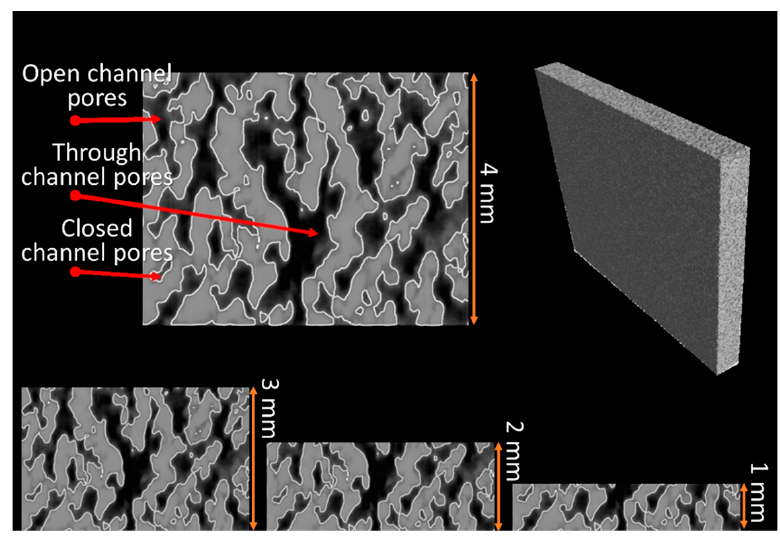
Figure 7. CT images of pores changing with thickness of samples. Vertical direction corresponds to the thickness direction of the samples. The inset of 1~3 mm represents the thickness of the samples.